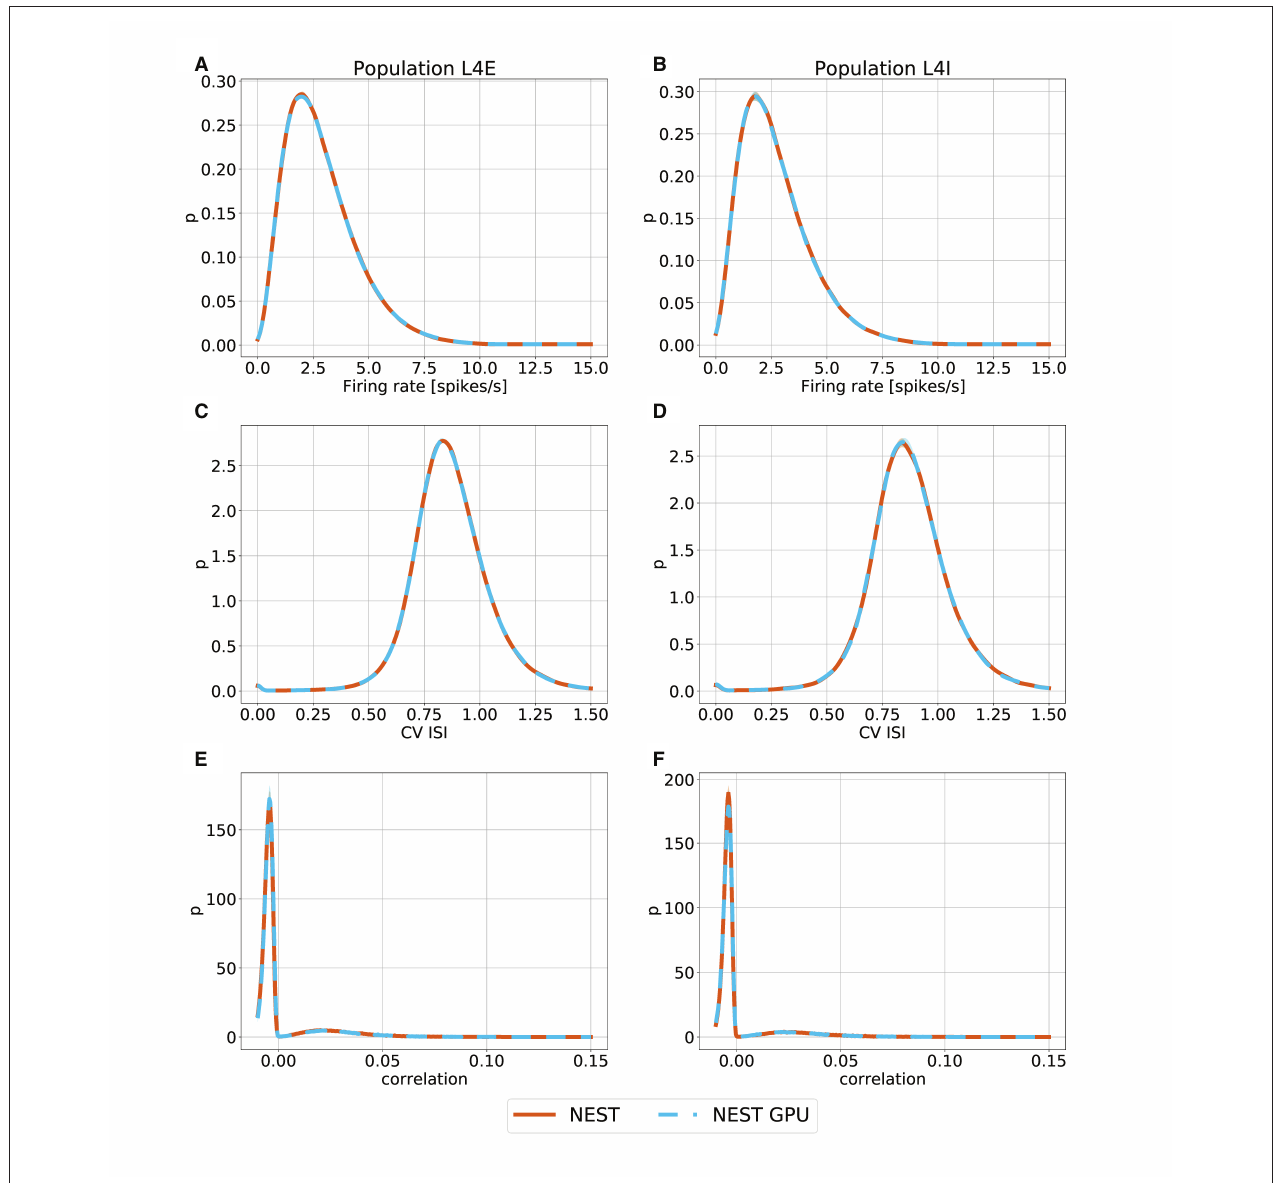
FIGURE 3 | Ground state distributions of firing rate (A,B) , CV ISI (C,D) and Pearson correlation of the spike trains (E,F) for the populations L4E and L4I of area V1. The distributions are averaged over 10 simulations with NEST (orange) and NEST GPU (sky blue). Every averaged distribution has an error band representing its standard